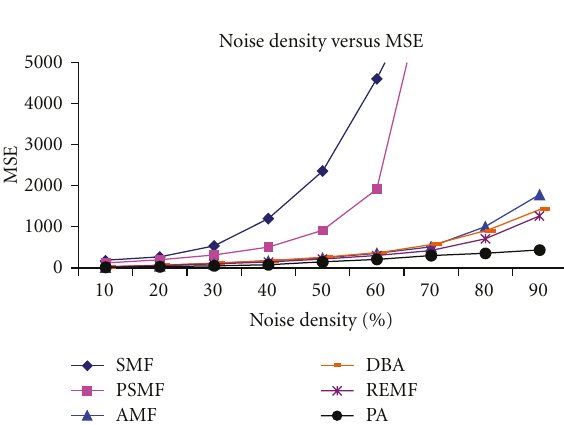
Figure 9: Noise density versus MSE for cameraman image.